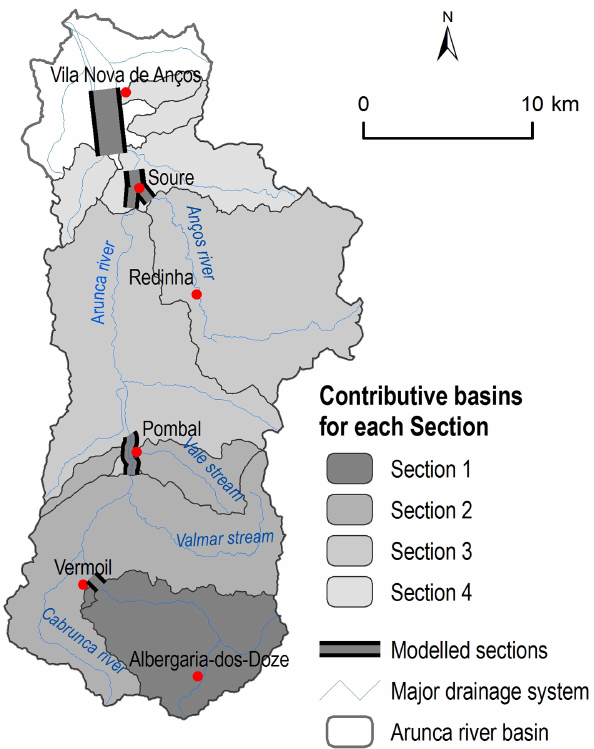
Fig. 6. Location of modelled sections and contributing drainage